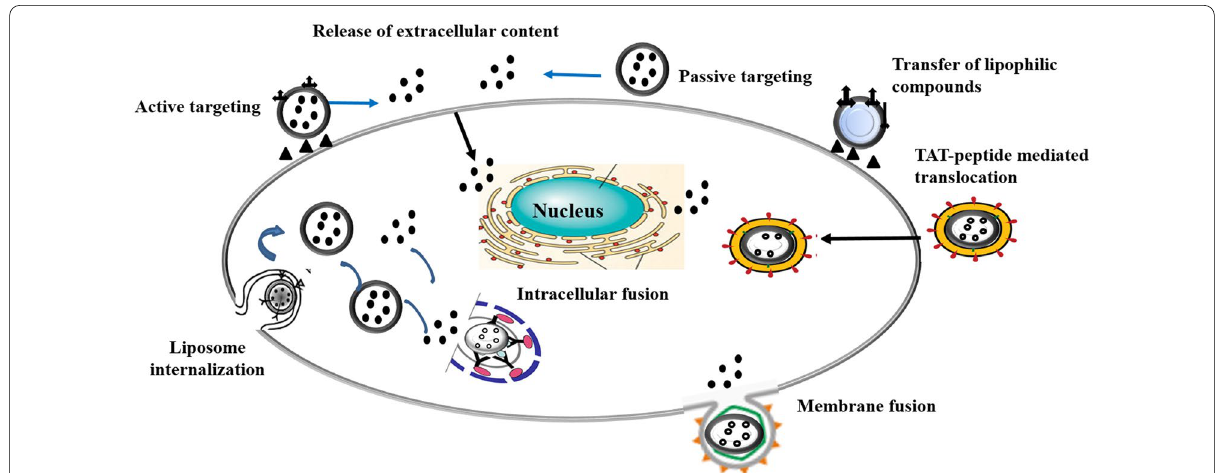
Fig. 5 Liposome as a drug delivery system (TAT—transactivator of transcription) (modified from Shaheen et al. 2006)